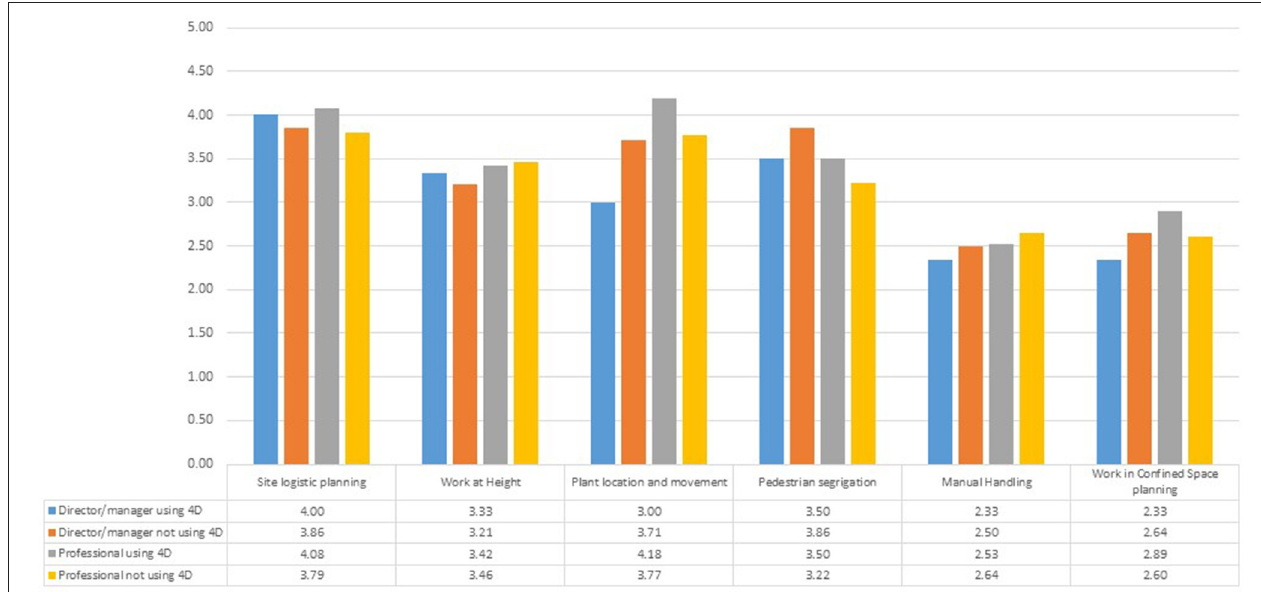
FIGURE 2 | Specific health and safety benefits of 4D modeling.